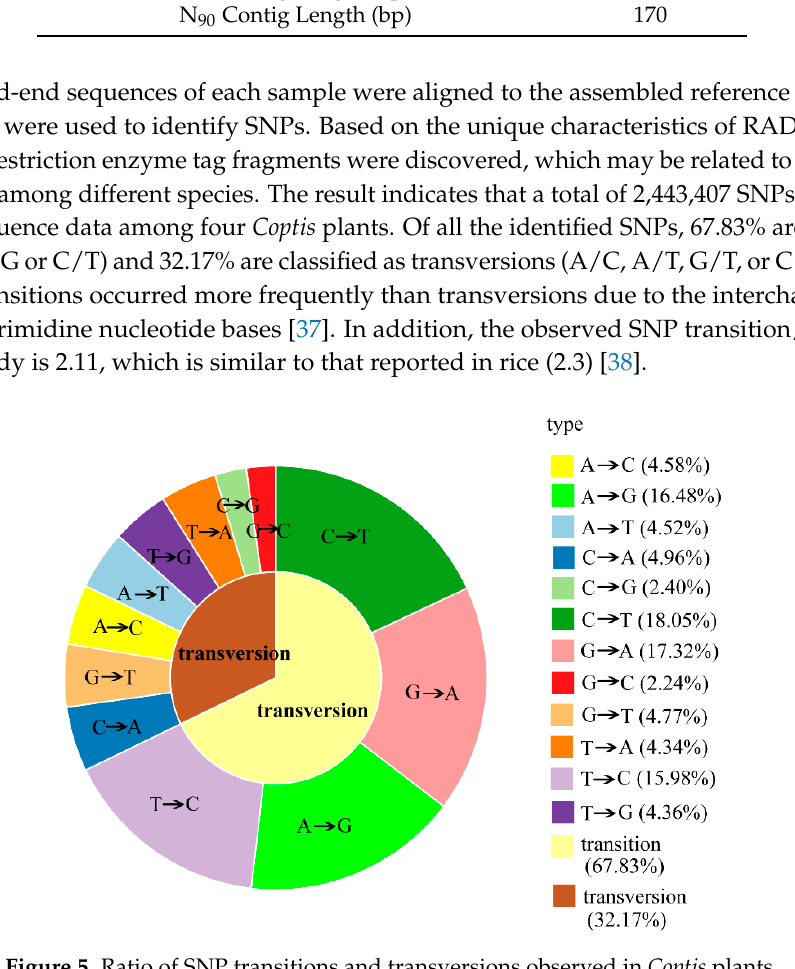
Figure 6. ( a ) Principal component analysis of the four Coptis plants based on identified SNPs; ( b ) Neighbor-joining tree based on identified SNPs. 3. Materials and Methods 3.1. Chemicals and Reagents